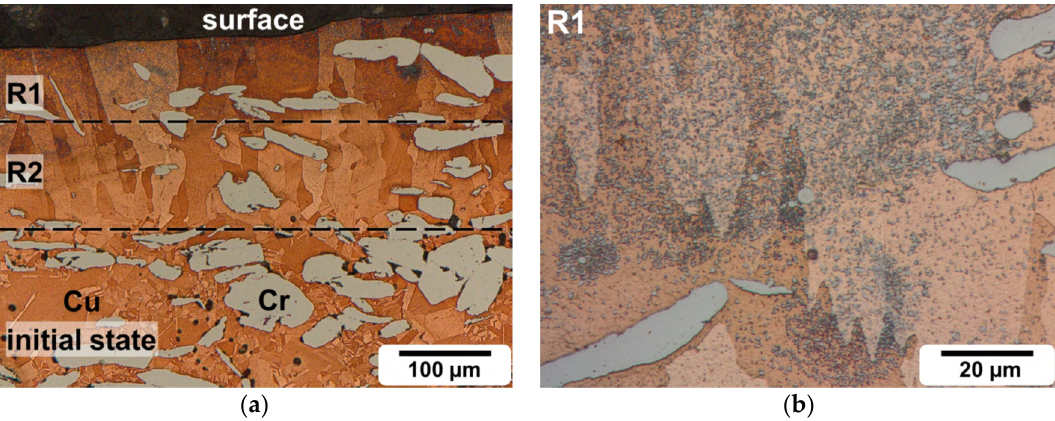
Figure 1. Optical micrographs of a cross section on the anode of CC75 subsequent to single current interruption ( I p = 6.25 kA, t arc = 10.4 ms, Q = 43.6 As). ( a ) R1 and R2 indicate two distinct regions with significantly different morphology; ( b ) Magnified section of R1.